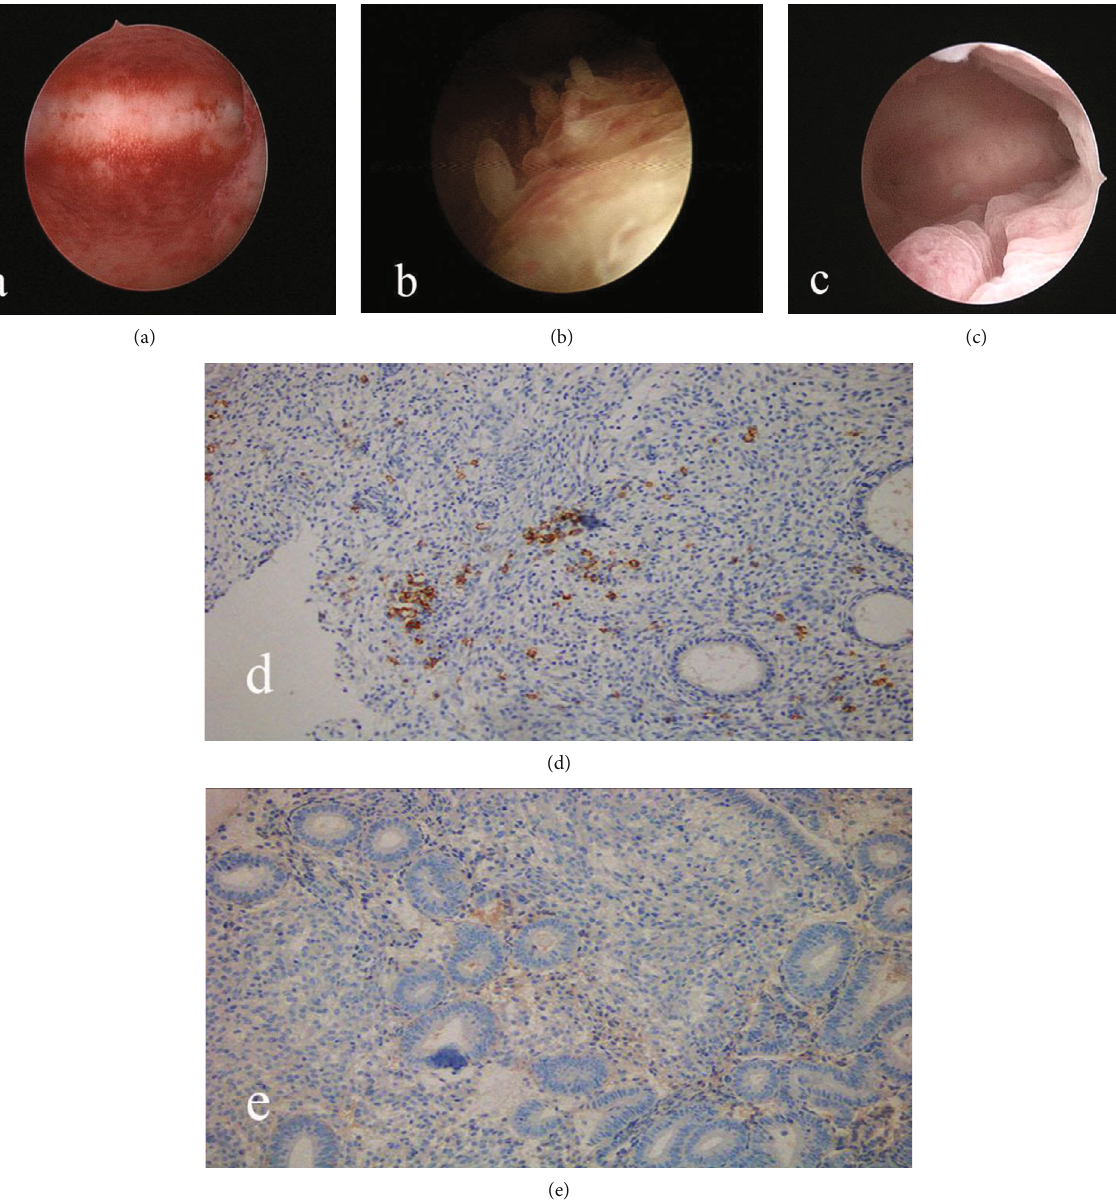
Figure 1: Di ff ering CE characteristics under fl uid hysteroscope. (a) Di ff use hyperemic endometrium. (b) Micropolyps ( < 1 mm). (c) Edema and hyperplasia. (d) Positive CD138 IHC staining (brown color) and > 5 plasma cells within endometrial stroma were positively stained using CD138 antibody ( × 400 pi). (e) Negative CD138 IHC staining and < 5 plasma cells were found within endometrial stroma ( × 400 pi). pi: pixels per